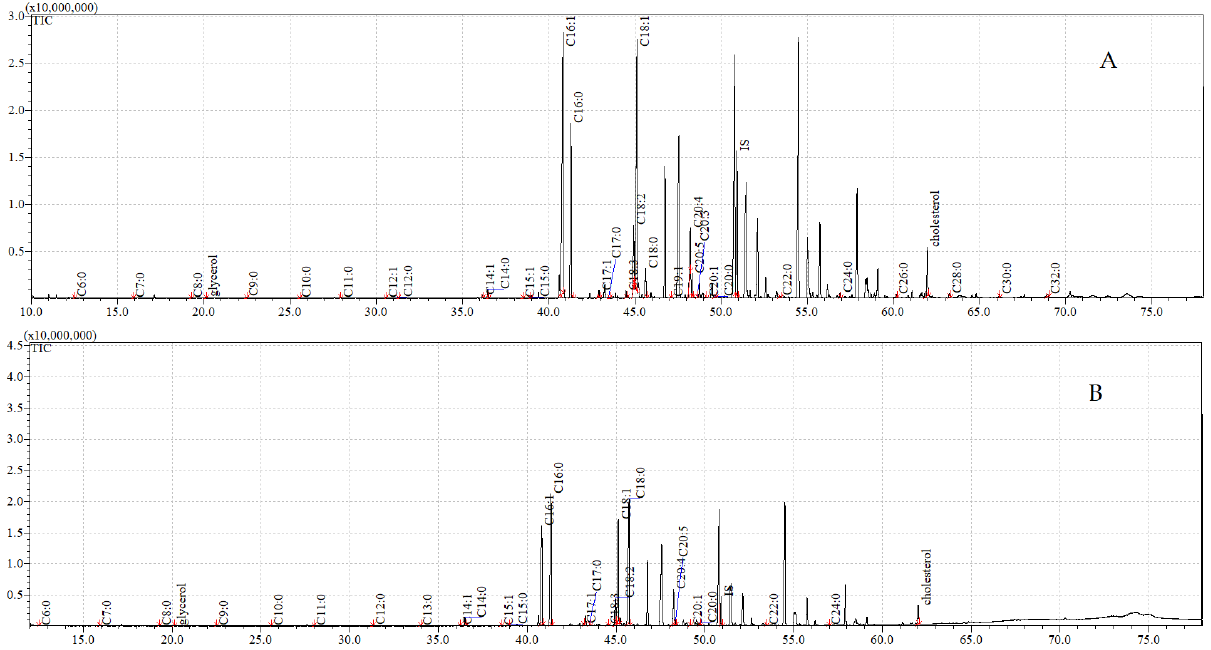
Figure 5. The total ion current (TIC) chromatogram of fatty acids (TMS esters) of the ether extract (extract I) from control (A) and after C. coronatus exposition (B) S. argyrostoma imago . Internal standard (IS, 19-methylarachidic acid); the following fatty acids and molecular ions: hexanoic acid (C6:0, m / z = 188), heptanoic acid (C7:0, m / z = 202), octanoic